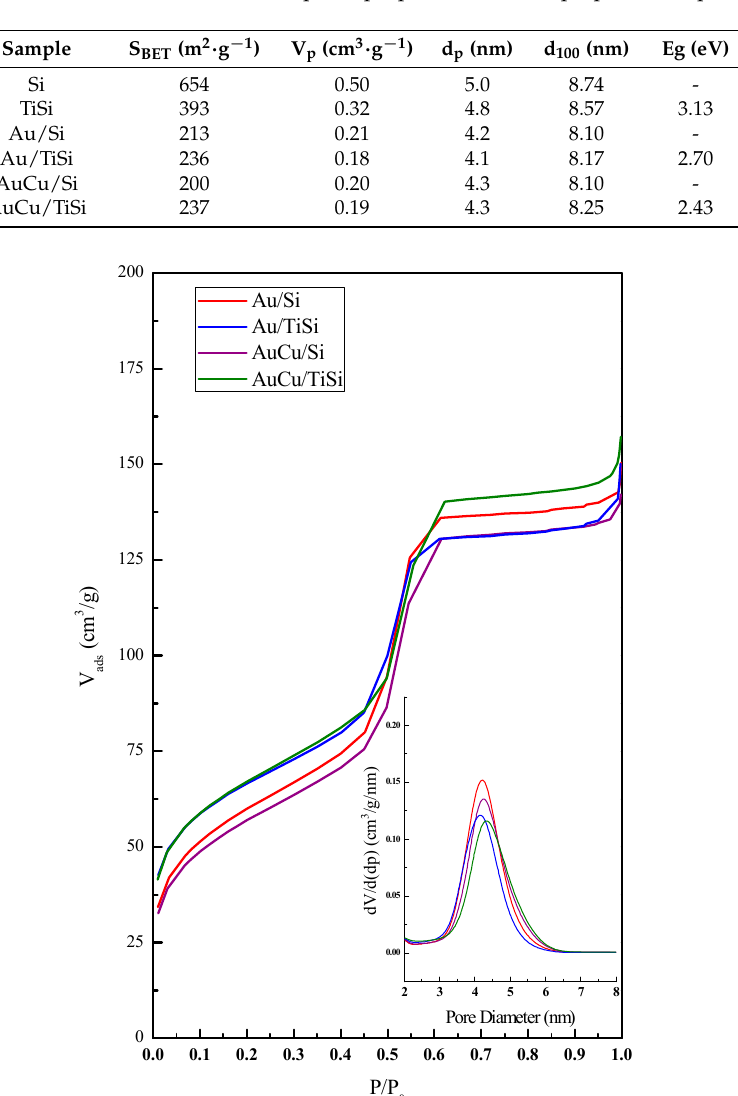
Figure 2. N 2 isotherms and pore size distribution (inset) for the silica and titania-silica-based photocatalysts.